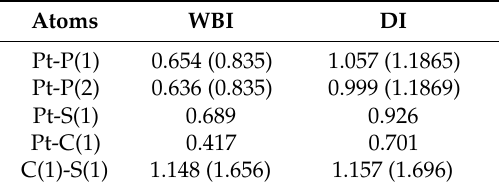
Table 2. Calculated natural bond orbitals (NBO) and quantum theory of atoms in molecules (QTAIM) indicators of bond order for the bonds around the Pt center in complex 3c . For some of the bonds, their order indices calculated for the isolated 1a and (dppf)Pt are presented in